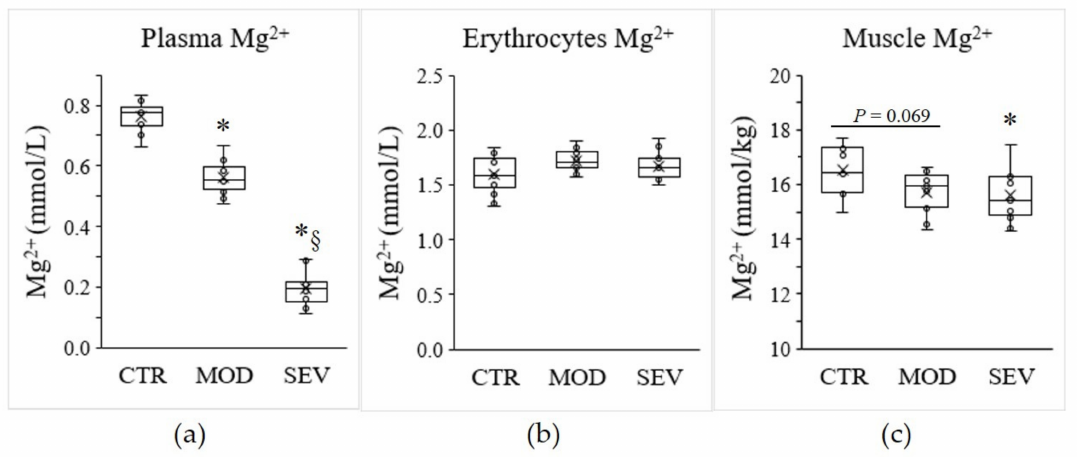
Figure 1. Mg 2+ status in mice. Mg 2+ concentrations were measured in ( a ) plasma, ( b ) erythrocytes, and ( c ) gastrocnemius muscle of mice fed either a control (CTR), a mildly (MOD), or a severely (SEV) Mg 2+ -deficient diet. Data (N = 12 per group) are presented as box-and-whisker plots (centerline, median; box limits, first and third quartiles; whiskers, 1.5 x interquartile range; points, outliers; x in the box, mean). * Significant difference ( P < 0.05) from the CTR group. § Significant difference ( P < 0.05) from the MOD